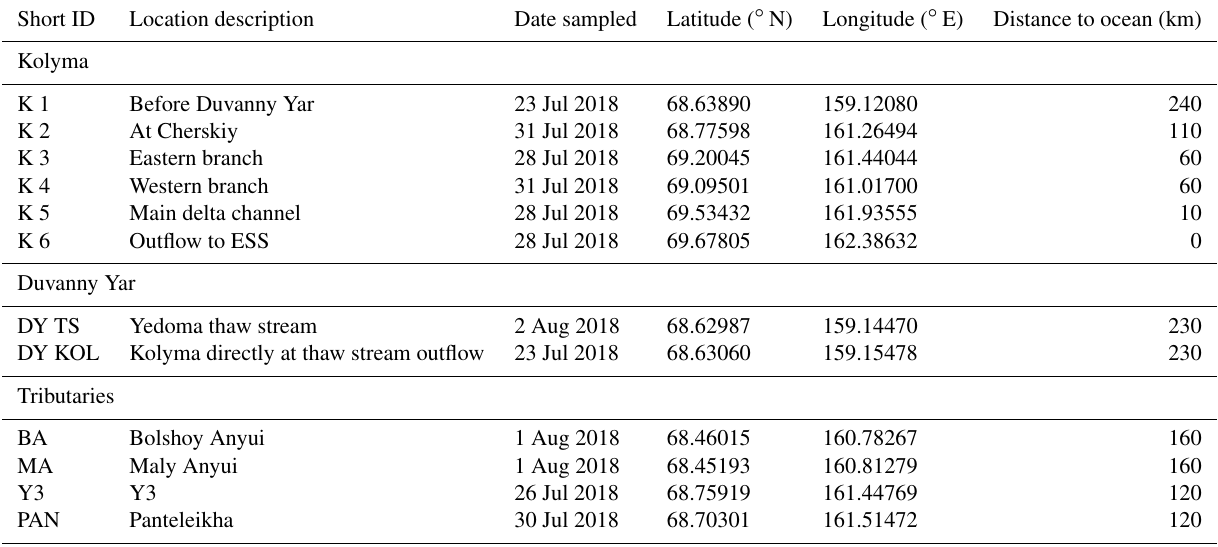
Table 1. Sample locations, description, sampling data, short ID, and the distance of each location to the mouth of the Kolyma River. Short ID Location description Date sampled Latitude ( ◦ N) Longitude ( ◦ E) Distance to ocean